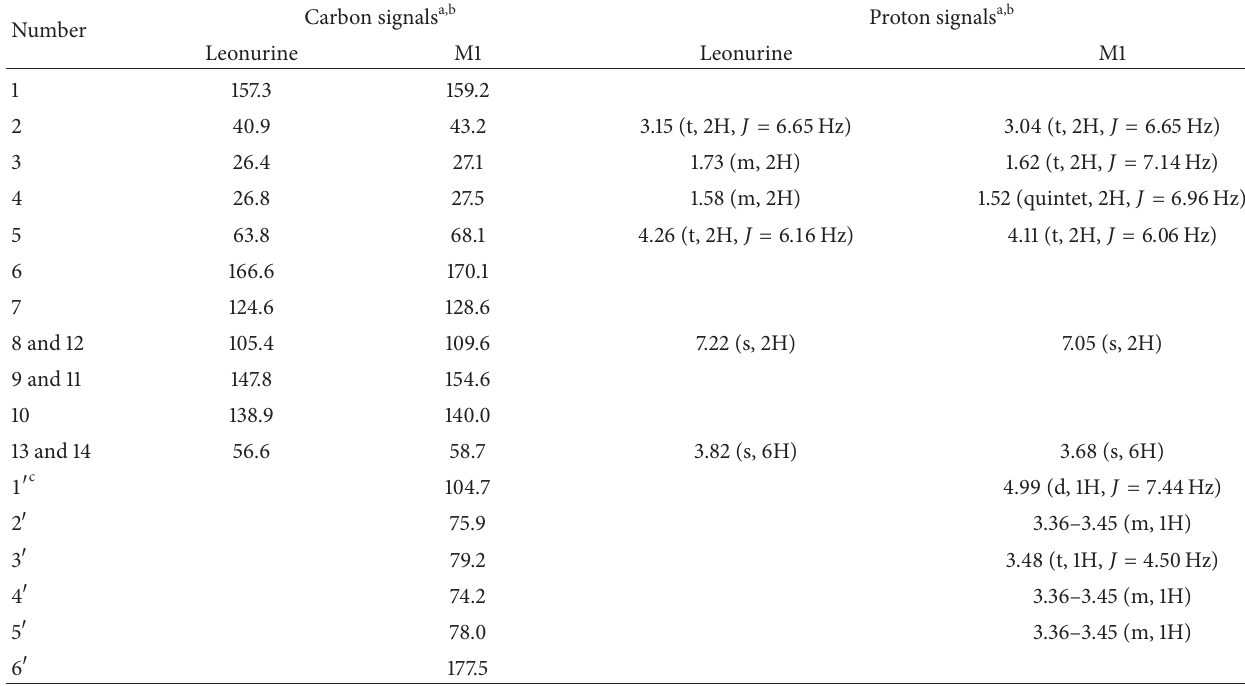
Figure 4: The semipreparative HPLC chromatogram of metabolite M1 in urine sample after intragastric administration of leonurine (a) and the purity analysis of the metabolite M1 acquired by semipreparative HPLC method (b). Table 3: The 13 C and 1 H NMR data for M1 and